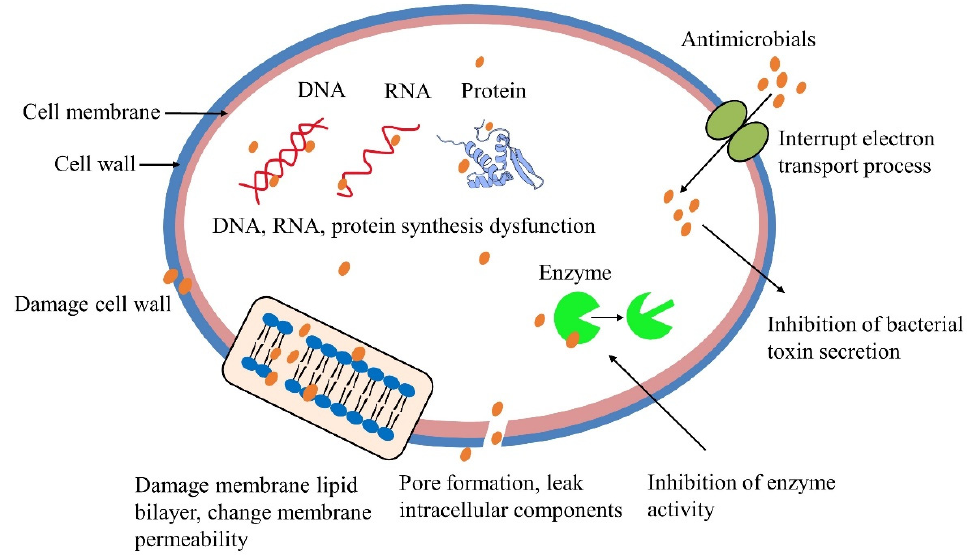
Figure 5. Antibacterial mechanism on microbial cells.